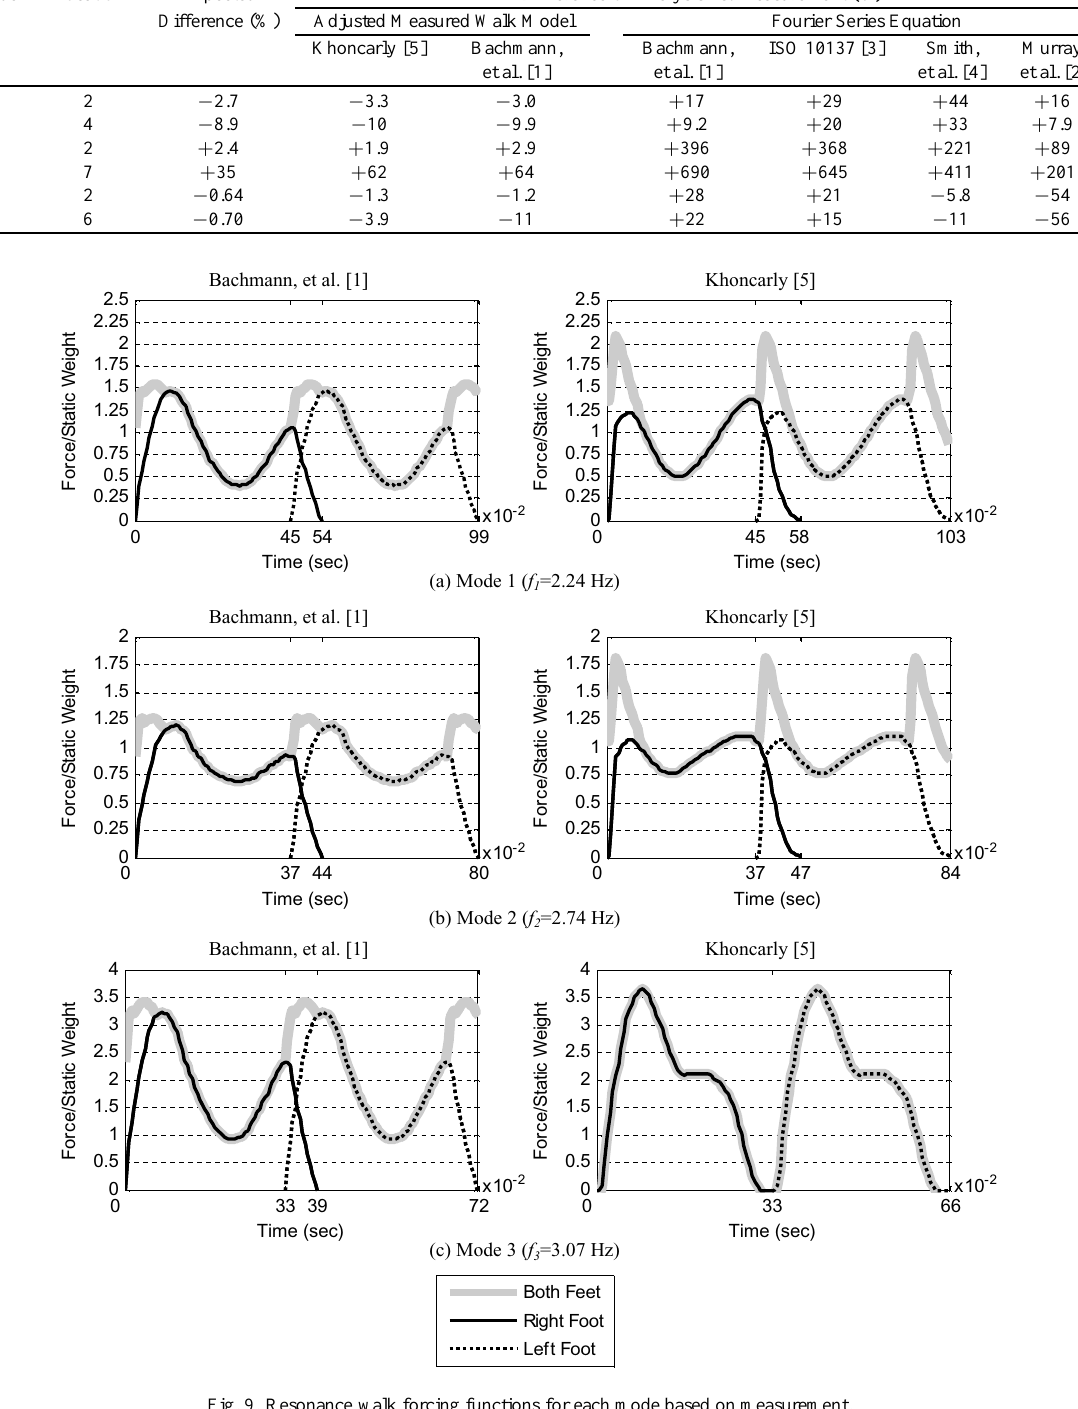
Fig. 9. Resonance walk forcing functions for each mode based on